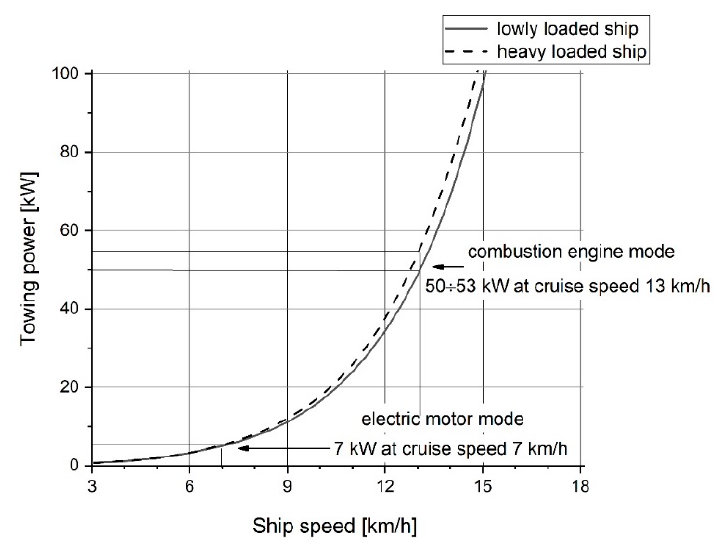
Figure 3. Graph of the power demand of the case study vessel as a function of speed for two loading states (lowly loaded ship and heavy loaded ship); two analysed modes of hybrid propulsion operation (‘electric engine mode’ and ‘combustion engine mode’) were selected.